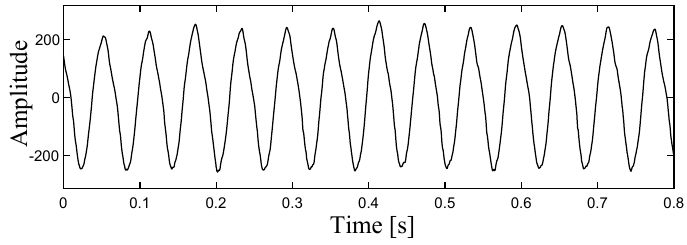
Figure 28. The time domain waveform of the displacement signal.